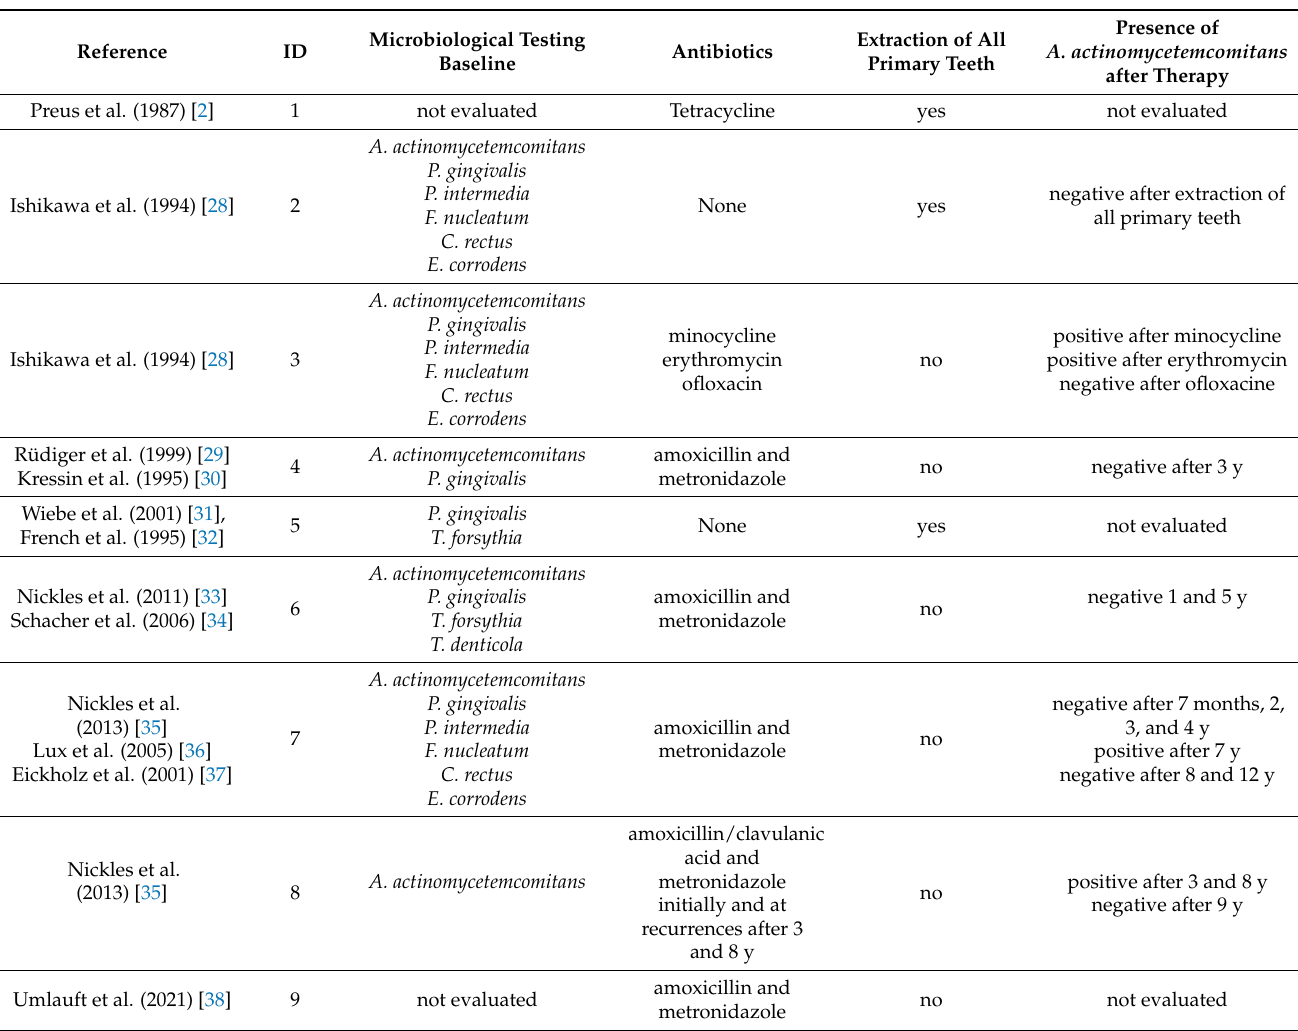
Table 2. Microbiolocigal findings in patients with Papillon–Lef è vre syndrome. The presence of nucleatum, Campylobacter rectus , and Eikenella corrodens before and/or after periodontal therapy was